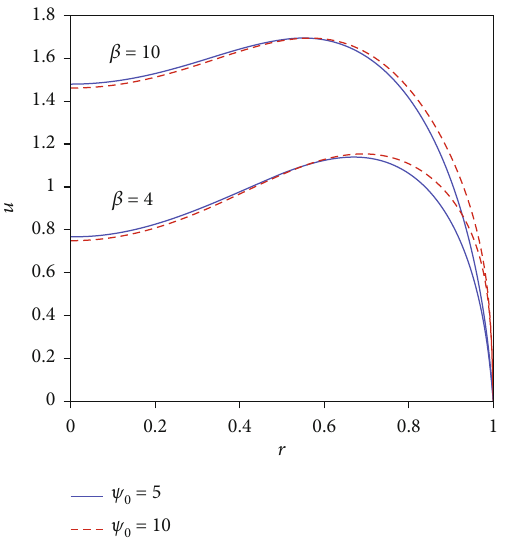
Figure 7: Dimensionless velocity distribution in a circular microchannel ( λ = 0 : 7, λ = 0 : 08, Ω = 1, K = 10, t = 0 : 5, Ha = 1 1 2